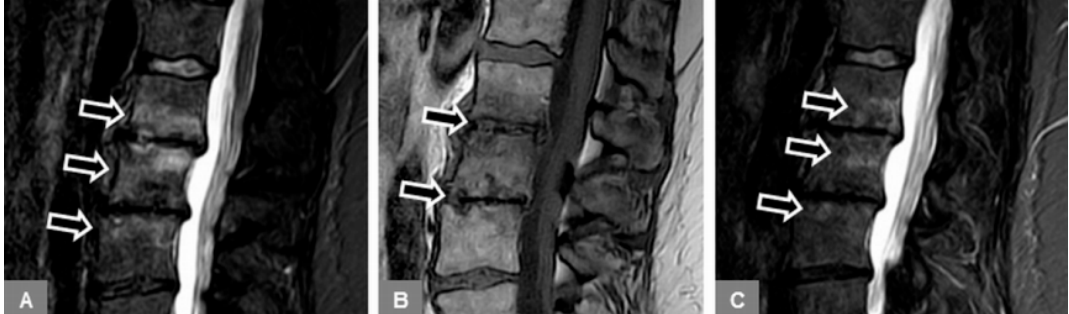
Figure 1. Modic type 1. A 52-year-old female patient with vertebral bone marrow edema on a sagittal STIR image at L1 to L3 ( A , arrows), and with marked irregular, yet intact endplate contours and disc space narrowing on a sagittal T1-w image ( B , arrows). There was a decrease of edema on a follow-up examination eight weeks ( C , arrows) after the initial presentation.